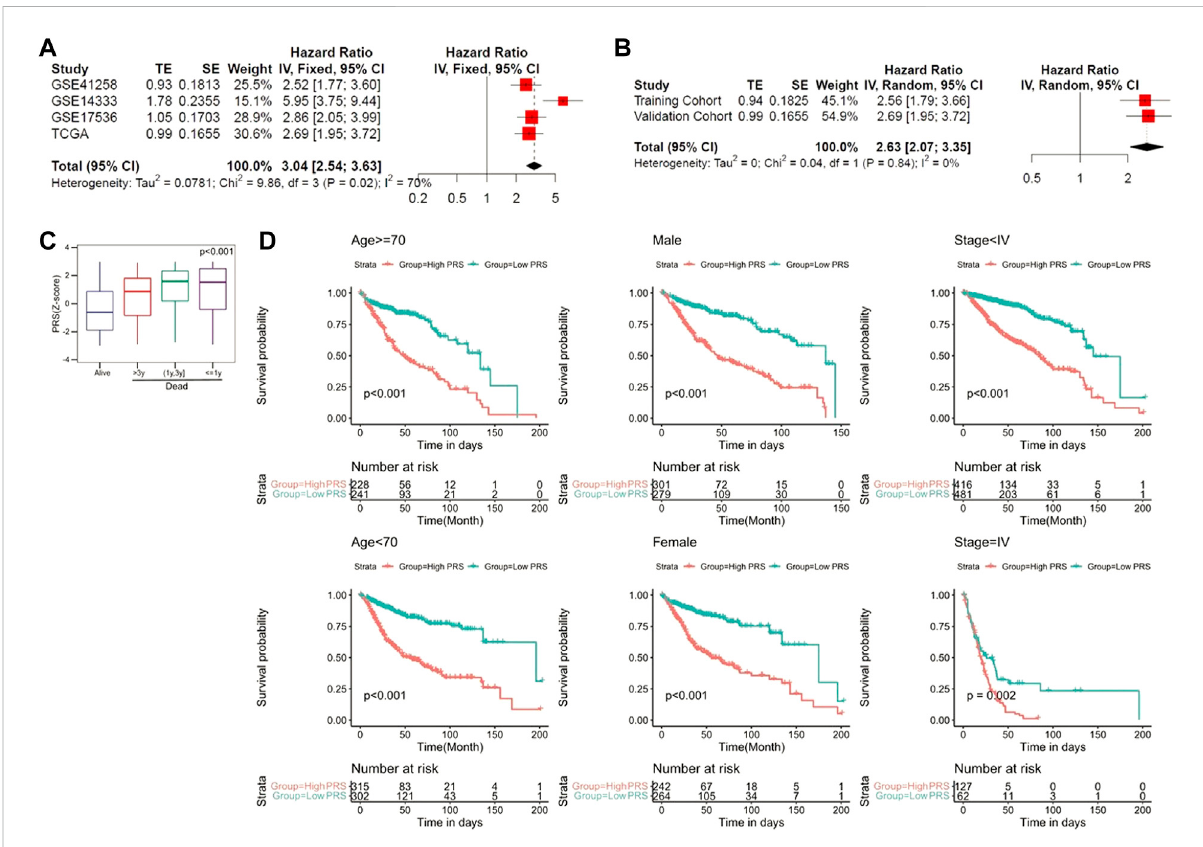
FIGURE 5 Thegenesignatureservesasavaluablemarkerforpoorsurvivalinthepooledcohort. (A) Meta-analysisinthetrainingandvalidationcohorts. (B) Meta-analysis for subgroup analysis. (C) PRS Z-scores were signi fi cantly elevated in deceased patients. (D) PRS discriminated high-risk patients in different clinicopathological including gender, age, and